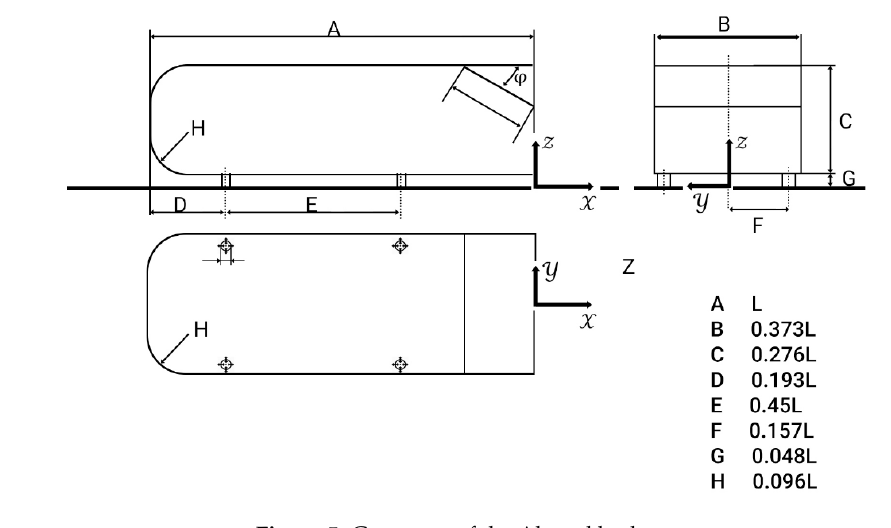
Figure 5. Geometry of the Ahmed body.